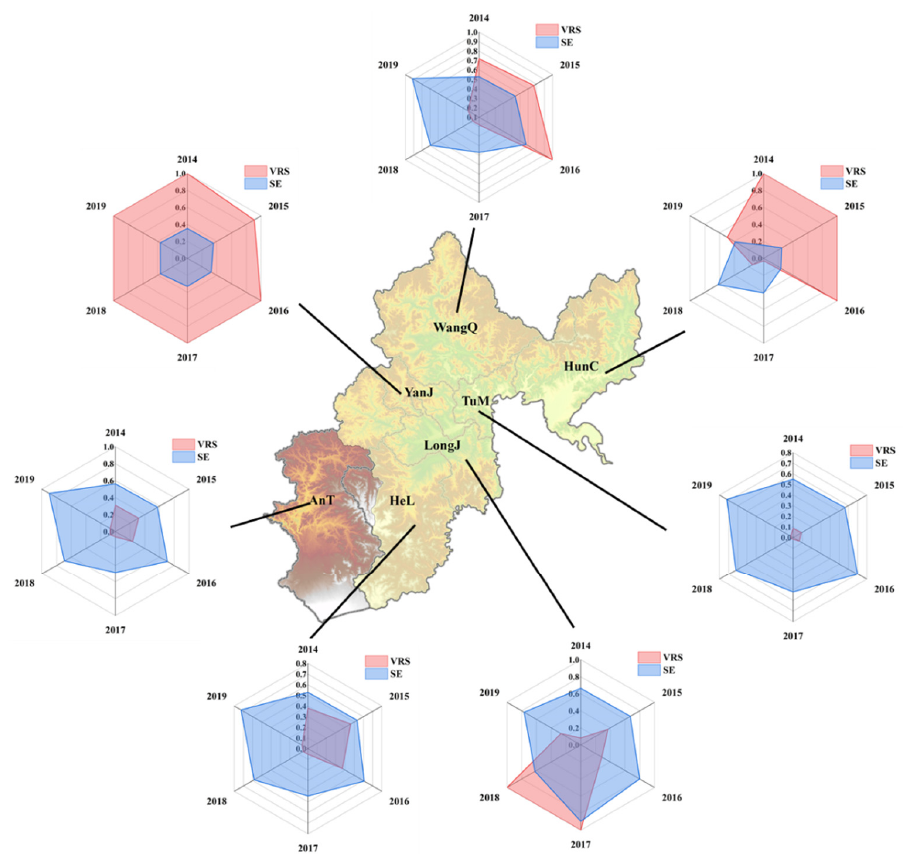
Figure 12. The trend of industrial water efficiency from 2014 to 2019.